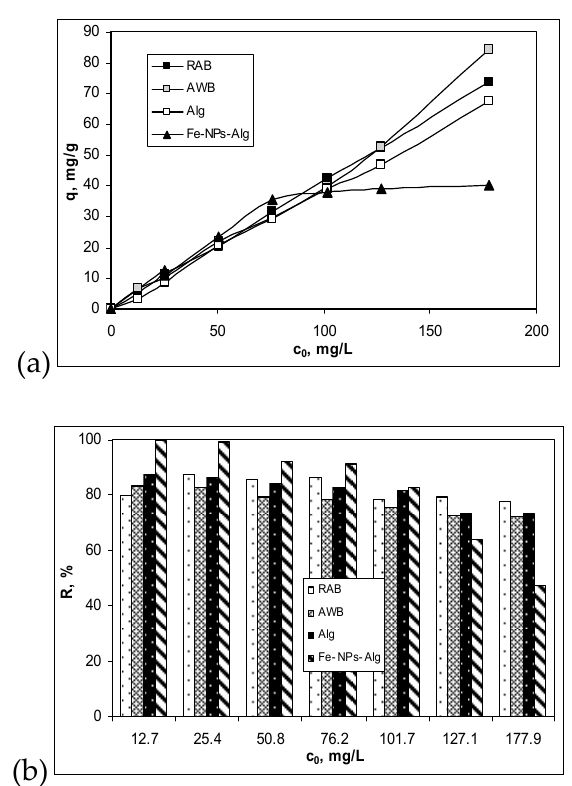
Figure 5. Influence of initial Cu(II) ions concentration on the adsorption capacity ( a ) and removal percent ( b ) for the studied adsorption processes.